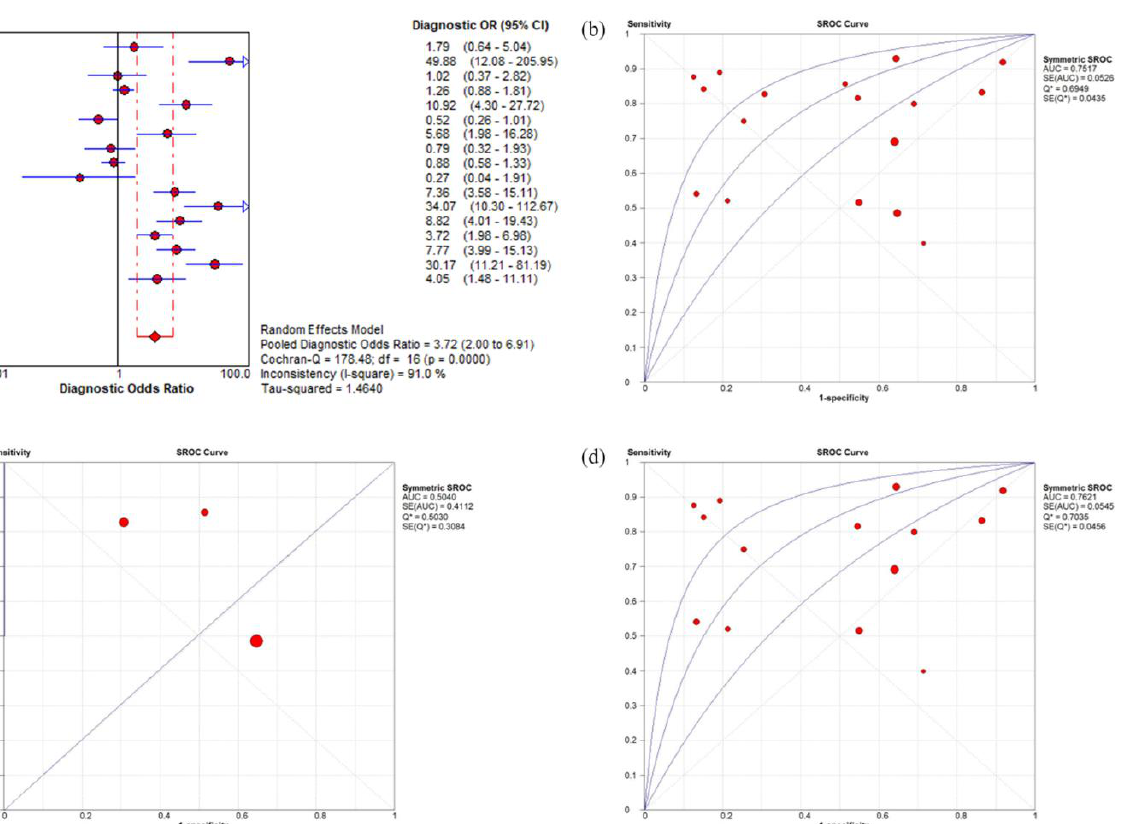
Table 2. Pooled estimates for diagnostic accuracy of serum IMA level for acute coronary syndrome.